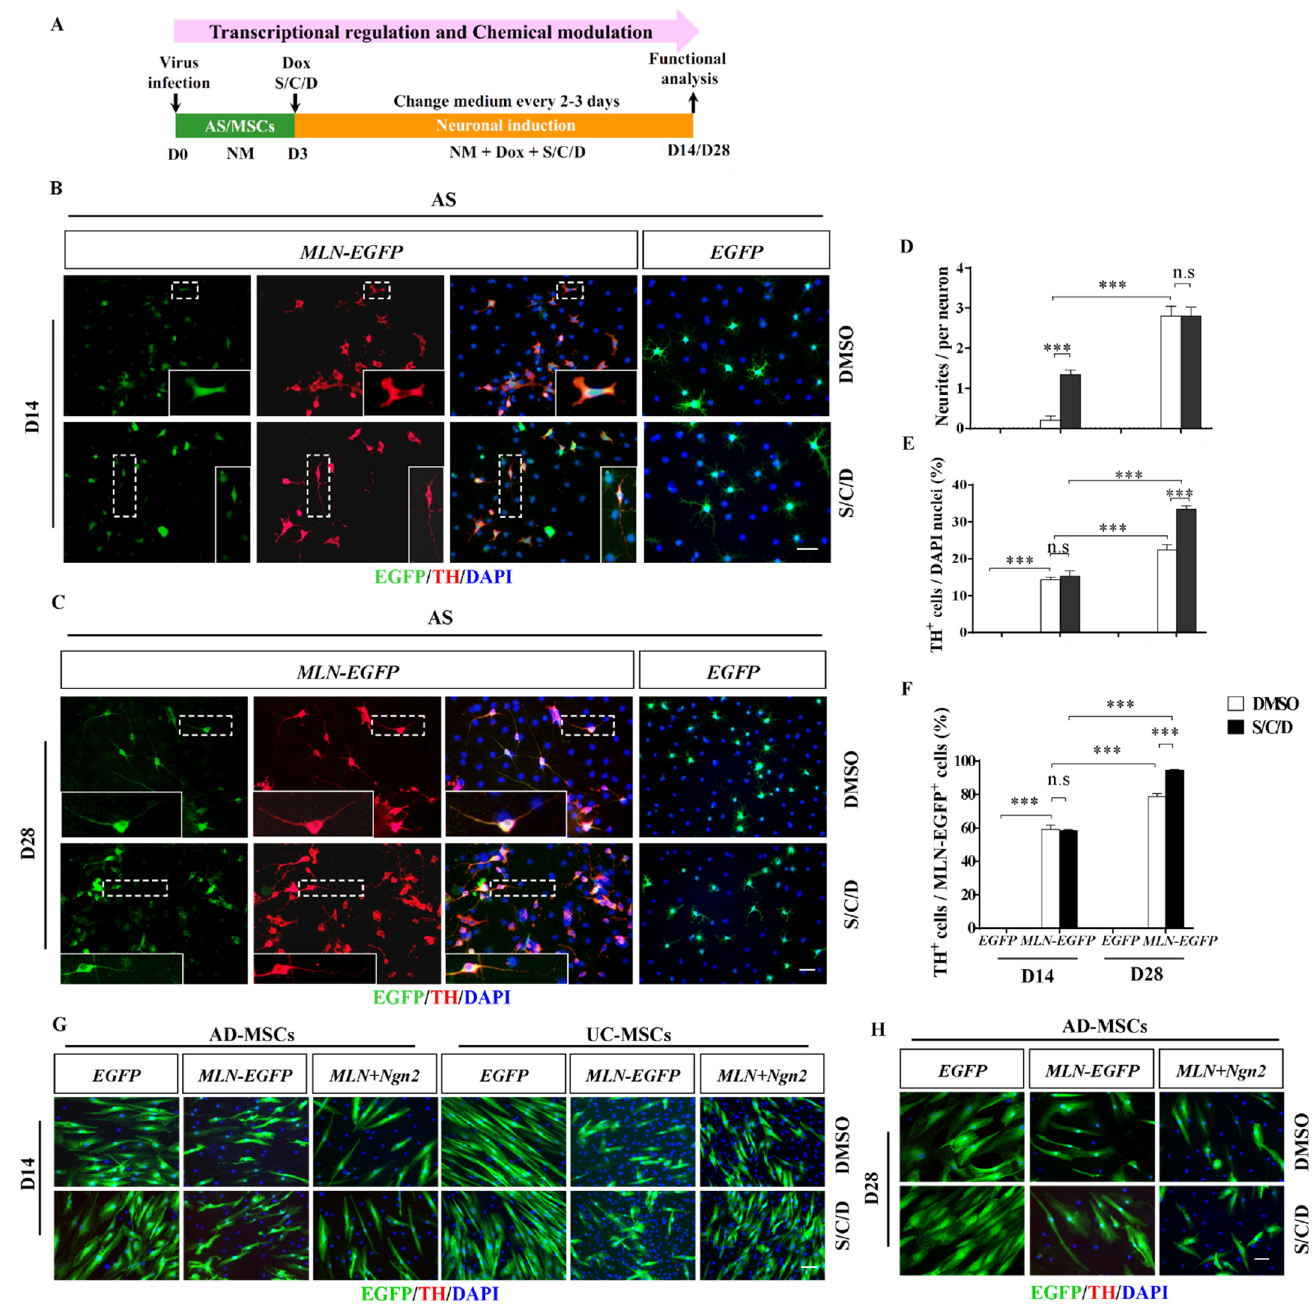
Figure 5. Improvement of the DA induction efficiency and maturation in AS but not MSCs by a combination of the transcriptional and the chemical modulation. ( A ) The paradigm of DA induction by the transcriptional regulation and the chemical modulation. AS, UC-MSCs, or AD-MSCs were infected with lentivirus carrying MLN-EGFP or EGFP (control) and then treated with NM containing Dox and chemicals S/C/D to initiate both the transcriptional and chemical induction. The induction system was terminated and stained for various DA markers on the 14th or 28th day for functional analysis. ( B , C ) The representative confocal images of AS being treated with MLN cocktail and S/C/D for 14 days ( B ) and 28 days ( C ). Cells were double stained for EGFP (infected cells), TH (DA neurons), and DAPI (cell nuclei). The area in the dashed box was enlarged and shown in the insets of each figure. AS infected with EGFP showed none of the TH-positive staining (the right column); in contrast, all the AS infected with MLN cocktail are stained positive for TH (the left 3 columns). Note that in Figure 5B, the induced TH-positive neurons extended more of neurites with the addition of S/C/D (the lower panel), as compared to the corresponding DMSO-treated group (the upper panel). ( D ) Numerical analysis of the neurites per TH-positive cell in the AS culture induced with MLN cocktail w/o S/C/D. The neurites with a length over 100 µm are included. ( E ) The effects of MLN cocktail and S/C/D treatment on the percentages of TH-positive cells in the AS induction system ( n = 3 independent experiments). ( F ) The effects of MLN cocktail and S/C/D treatment on the percentages of TH-positive cells